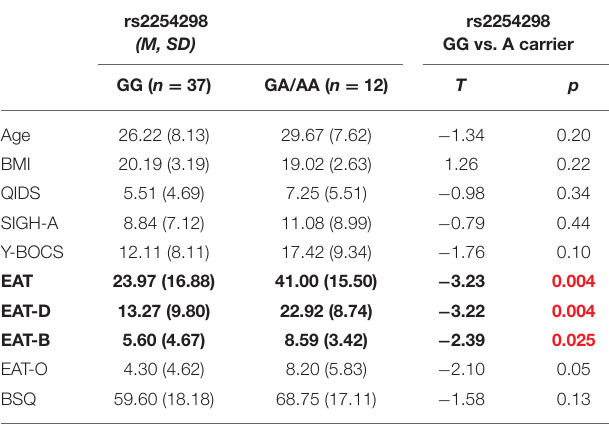
TABLE 1 | Demographic and clinical characteristics for OXTR SNP